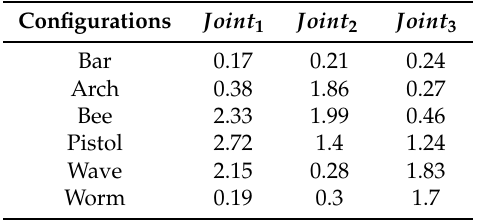
Figure 13. Current consumption by each hinged motors for six configurations—( a ) bar, ( b ) worm, ( c ) arch, ( d ) pistol, ( e ) bee, ( f ) wave configuration of the platform. Table 3. Power consumption (Watt) for each hinged motor during